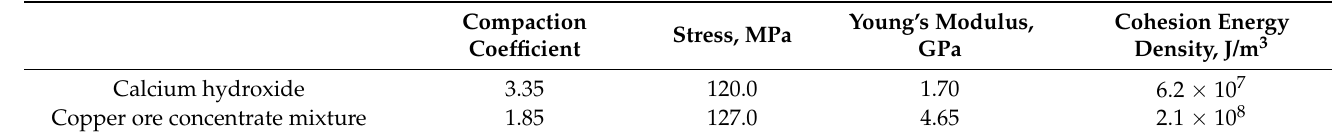
Table 1. Compaction characteristics of calcium hydroxide and mixture based on copper ore concentrate.